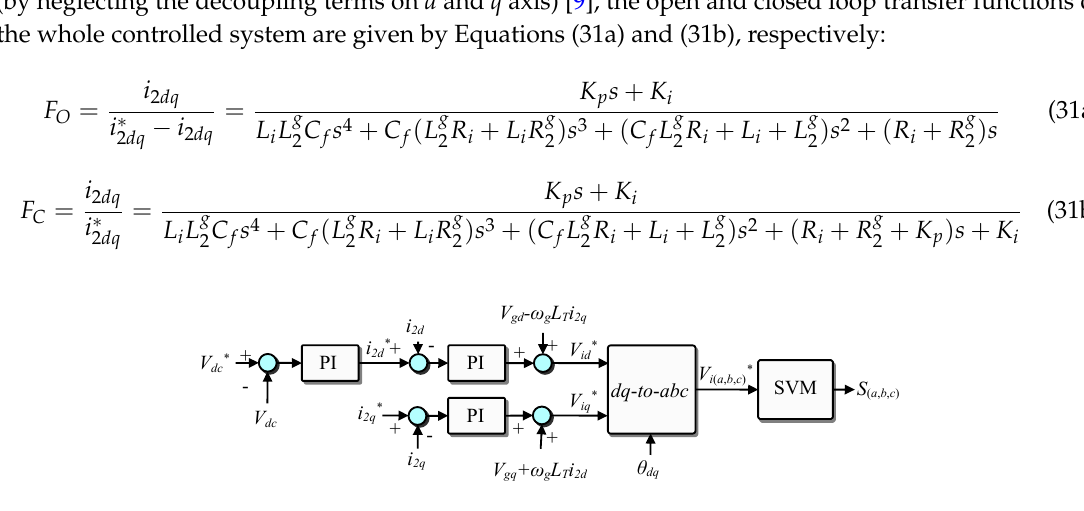
Figure 6. Resonance frequency according to grid inductor and filter capacitor accuracy.